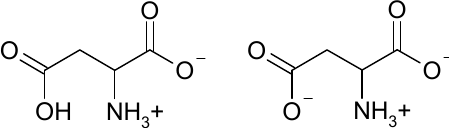
Figure 2. The structure of Asp ± and Asp − ions.